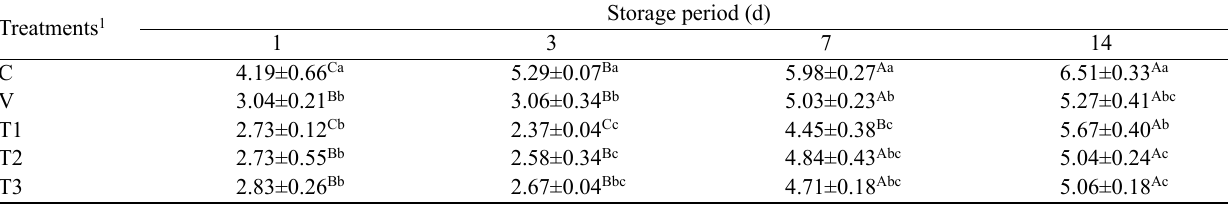
Values represent the mean of triplicate